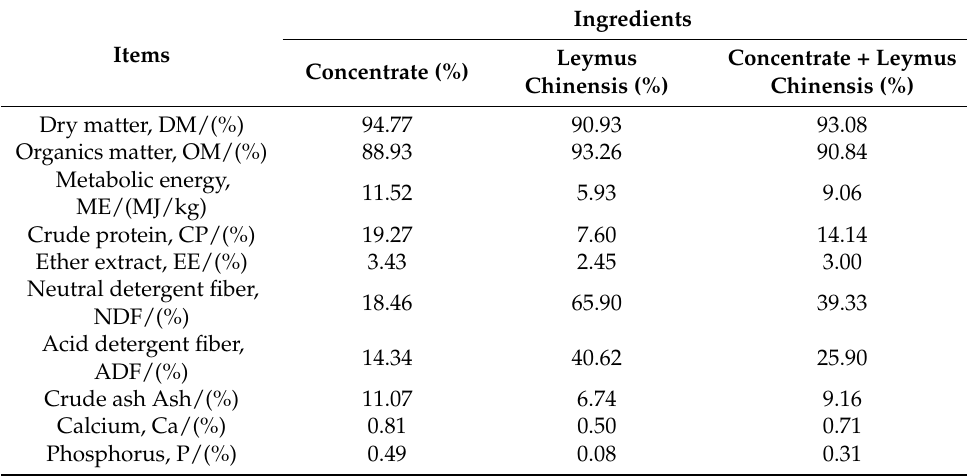
Table 1. Composition and nutrient levels of diets (DM basis%).